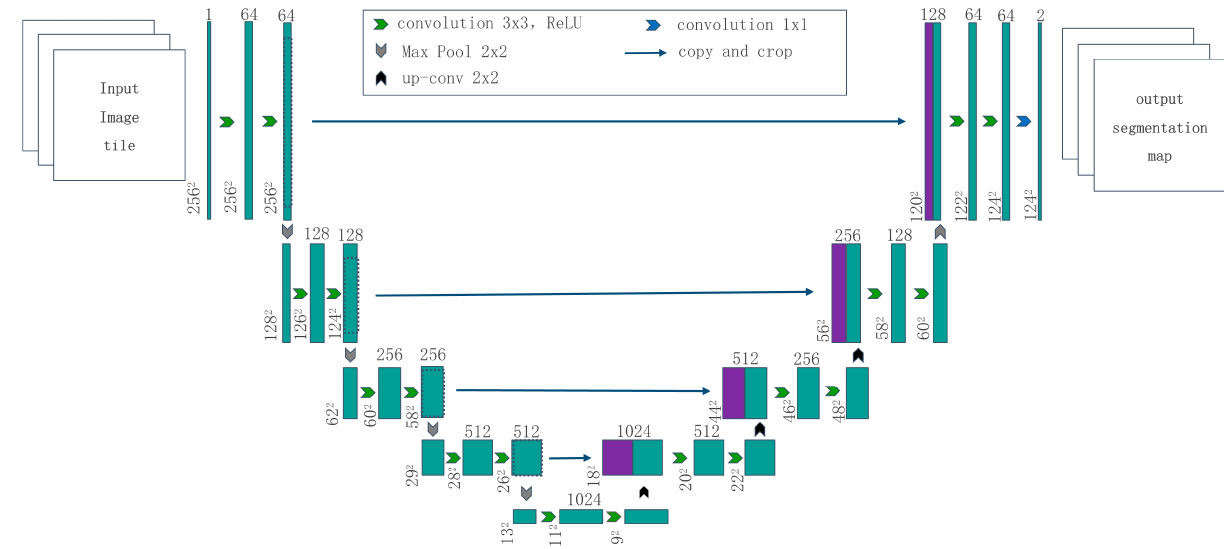
Figure 2. U-Net architecture. Figure 2. U‑Net